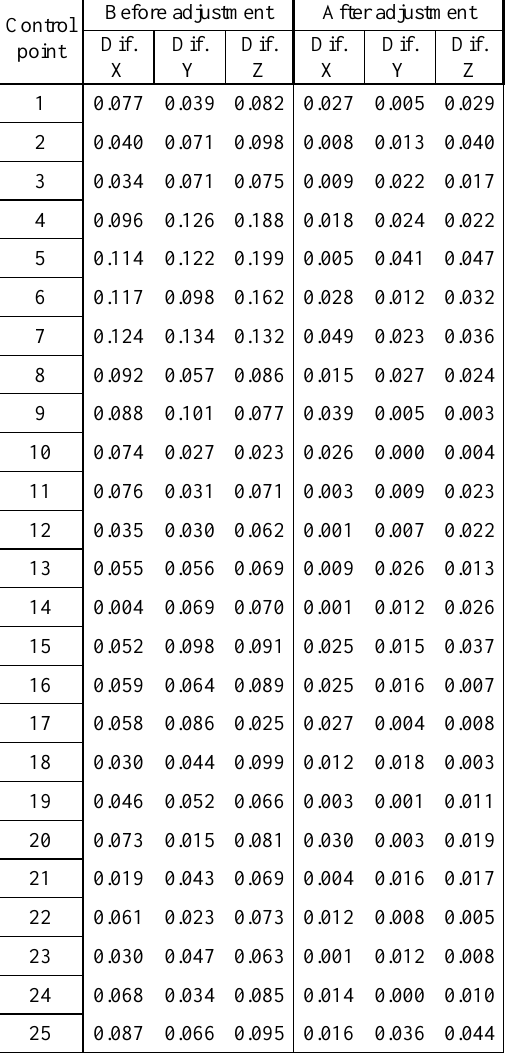
Figure 10. Values in meters to be applied for each of the points along the trajectory Table 1. Differences computed between the manually measured After the registration of all clouds of block B, a maximum point cloud and GNSS coordinates of each control point, before vertical difference of 2 cm was measured along the trajectory. and after adjustment This value is detected between the clouds of block B relative to the clouds of block A. The differences measured before the registration varied between 5 and 55 cm. A longitudinal profile along a crossing street trajectory before and after the registration is presented in Figure 11.